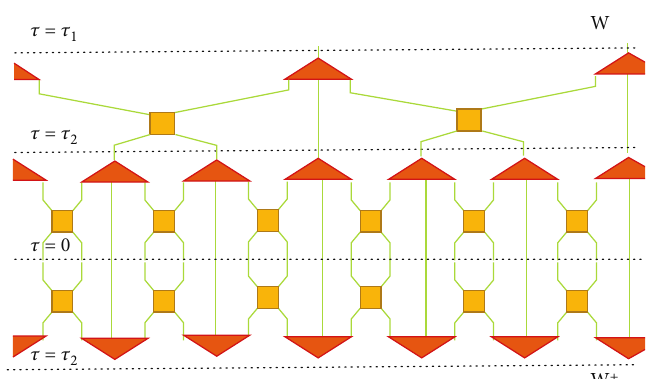
Figure 1: The MERA tensor network is a circuit W made of disentangler (boxes) and isometry (triangles) operations. More precisely, W Þ is given by the product of all the tensors between the lines τ = τ ð τ , τ 2 1 ). The Euclidean times τ to high-energy states ( τ = τ 2